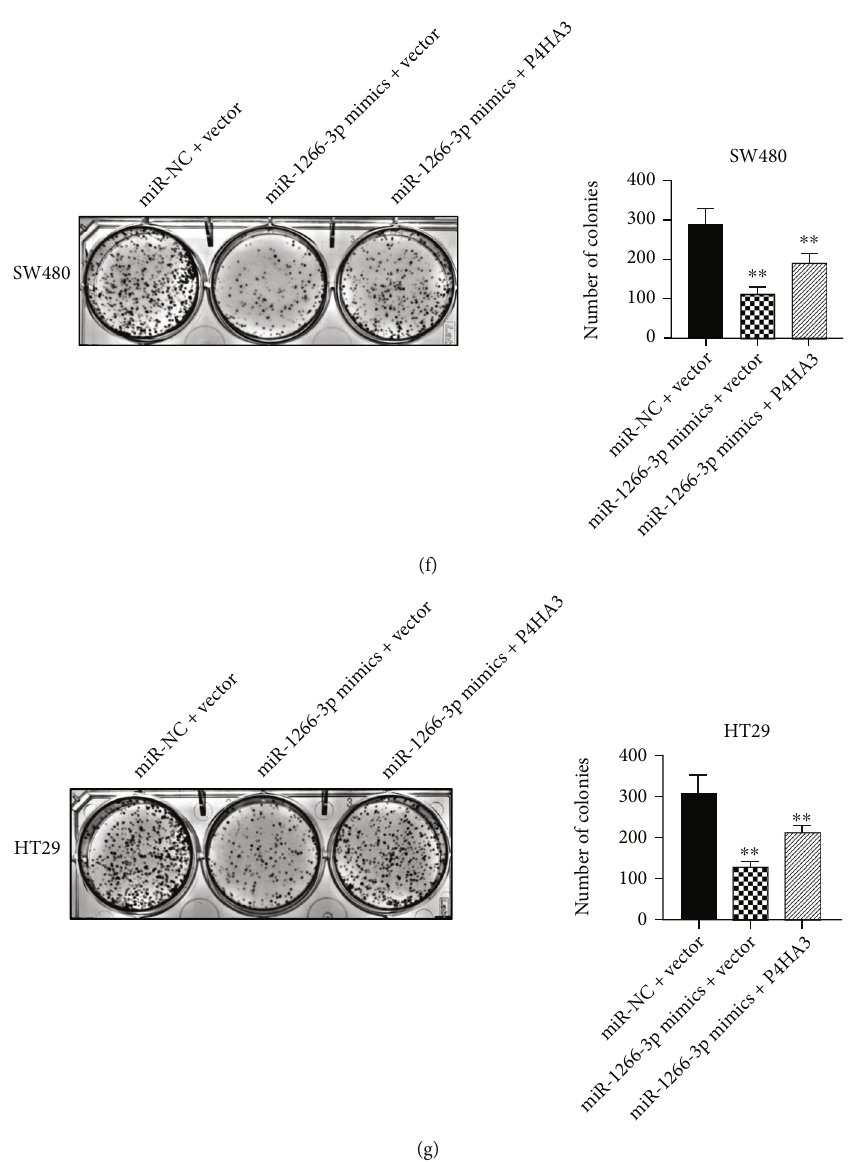
Figure 3: MiR-1266-3p inhibited proliferation and clone formation of colon cancer cells, and this e ff ect could be alleviated by overexpressing P4HA3. (a – b) QRT-PCR indicated that miR-1266-3p expression increased and P4HA3 expression decreased after transfecting miR-1266-3p into SW480 and HT29 cells, whereas overexpression of P4HA3 could reverse the e ff ect. (c) Western blot indicated that P4HA3 expression decreased after transfecting miR-1266-3p into SW480 and HT29 cells, whereas overexpression of P4HA3 could reverse the e ff ect. (d – e) CCK8 assay revealed the reversal e ff ects of P4HA3 overexpression on miR-1266-3p-mediated clone formation ability of SW480 and HT29 cells ( ∗∗ P < 0 : 01